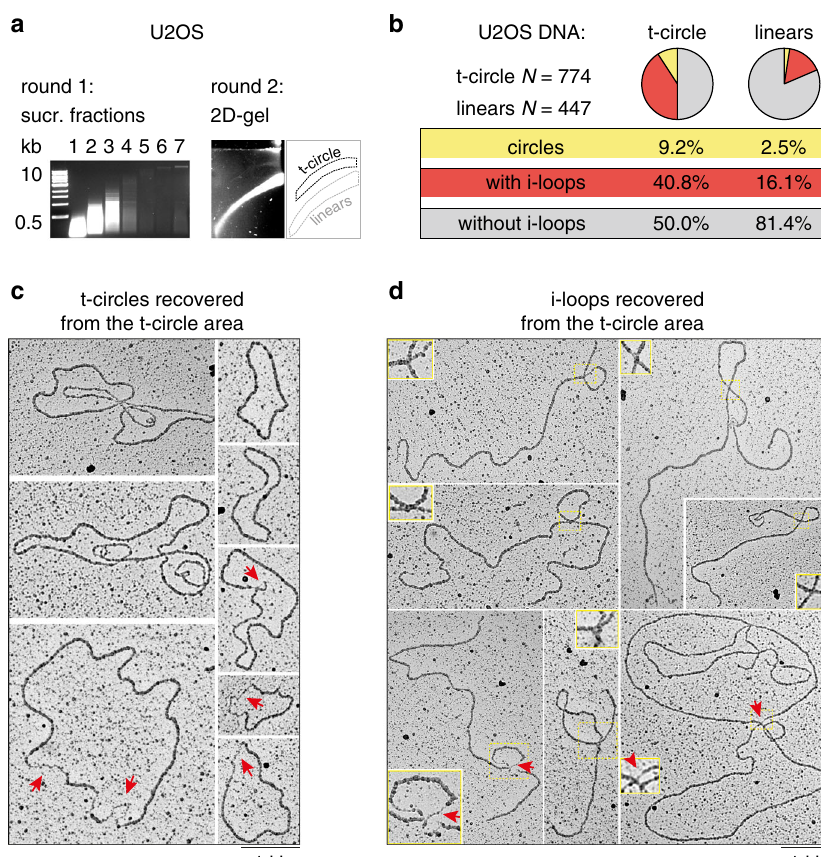
Fig. 4 I-loops are the majority of telomeric structures detected at ALT telomeres. a Procedure for the puri fi cation of telomeric DNA migrating in the linear and the t-circle arc of ALT telomeres. Genomic DNA ( ∼ 2.5 mg) extracted from U2OS cells was processed for the telomere enrichment procedure as described in Fig. 1a. The HMW DNA, contained in the last 4 fractions of the sucrose gradient, was collected, digested again as described in Fig. 1b and separated in a 2D-gel. A strong linear signal and a faint t-circle arc were visible in the second-dimension gel (right). These areas were excised and the DNA was recovered from the gel. Source data are provided as a Source Data File. b Pie chart showing the distribution of the molecules recovered from the 2D- gel. Percentages of the 3 major categories are shown. Note that i-loops can occur also in molecules having a t-loop at the end, or at branched molecules. This sub-distribution is reported in Supplementary Fig. 5b. c Example of circular molecules found in the DNA puri fi ed from the t-circle arc. Arrows indicate regions of single-stranded DNA. d Examples of i-loops found in the DNA puri fi ed from the t-circle arc. Insets represent 2X enlargements of the areas inside the yellow rectangles. Red arrows indicate regions of single-stranded DNA at the loop